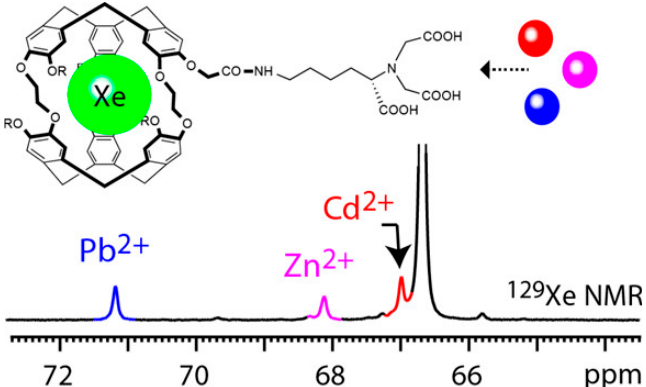
Figure 2. 129 Xe NMR spectrum of the cryptophane sensor in the presence of Pb 2+ , Zn 2+ , and Cd 2+ cations, each with a 48.5 μ M concentration. Reprinted with permission from reference [71]. Copyright 2014 American Chemical Society.